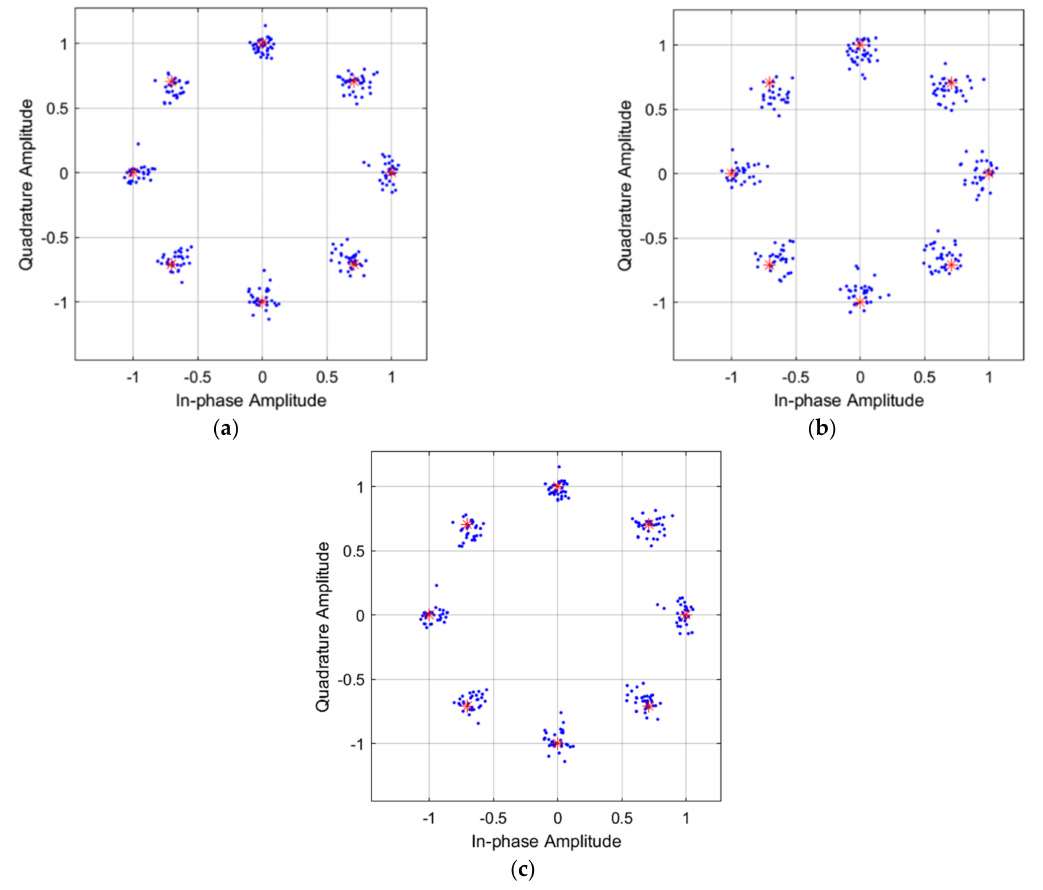
Figure 23. The constellation diagrams of 8 PSK for ( a ) case 1, ( b ) case 2, and ( c ) case